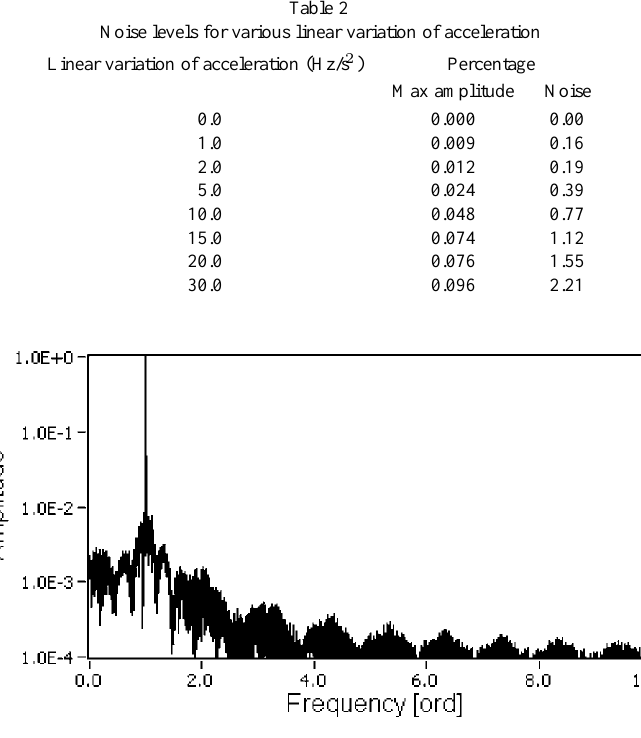
Fig. 16. Order spectrum of the simulated signal from a mining